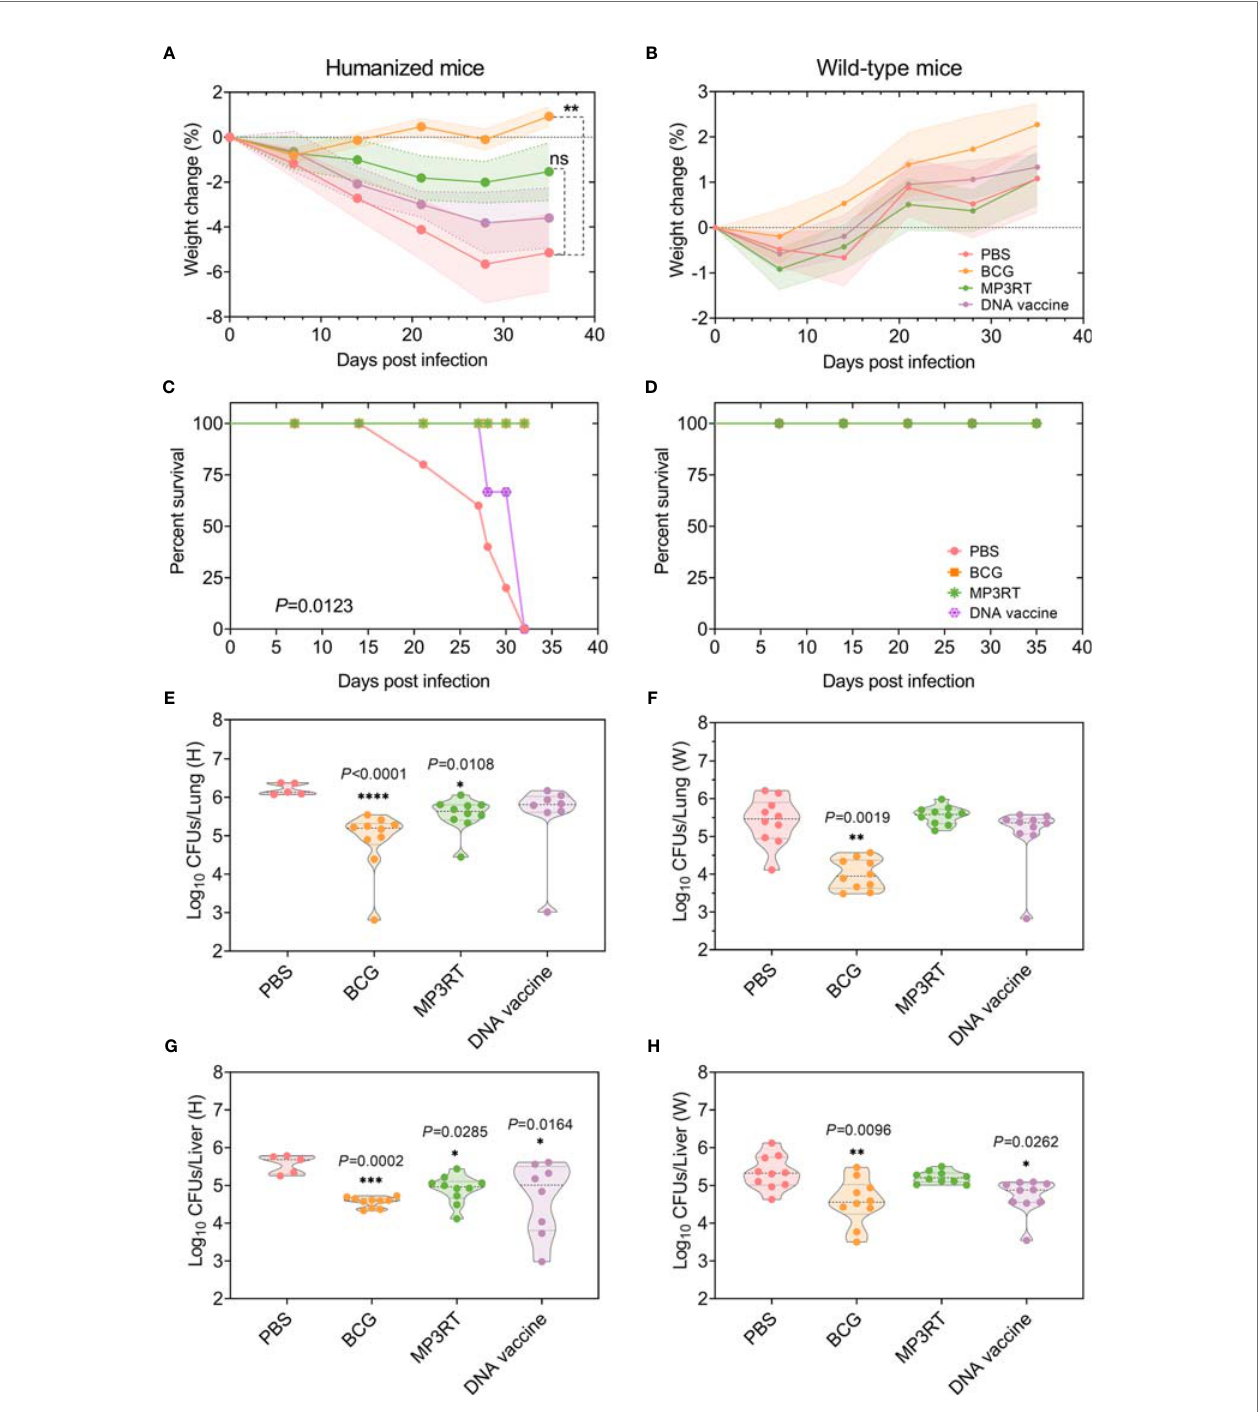
FIGURE 4 | Protective ef fi cacy of MP3RT vaccine in the mouse model. Humanized or wild-type C57BL/6 mice were immunized with PBS, BCG, MP3RT, and ag85ab DNA vaccine, respectively. On the 56 days after primary immunization, humanized or wild-type mice were challenged with M. tuberculosis H37Rv strain. The weight changes (A, B) and deaths (C, D) were recorded weekly or daily. Thirty- fi ve days post-infection, mice were sacri fi ced. The left lobe of the lung (E or F) and half part of the liver (G or H) collected from humanized or wild-type mice were used for CFUs counting. The data were expressed as Log 10 of CFUs and compared with one-way analysis of variance (ANOVA) or Kruskal-Wallis test according to the data normality and homogeneity of variances. All data were shown as mean + SEM ( n = 5 in humanized mice vaccinated with PBS and n = 10 in other groups). P <0.05 was considered signi fi cantly different. * P < 0.05; ** P < 0.01; *** P <0.001; **** P < 0.0001, ns, no signi fi